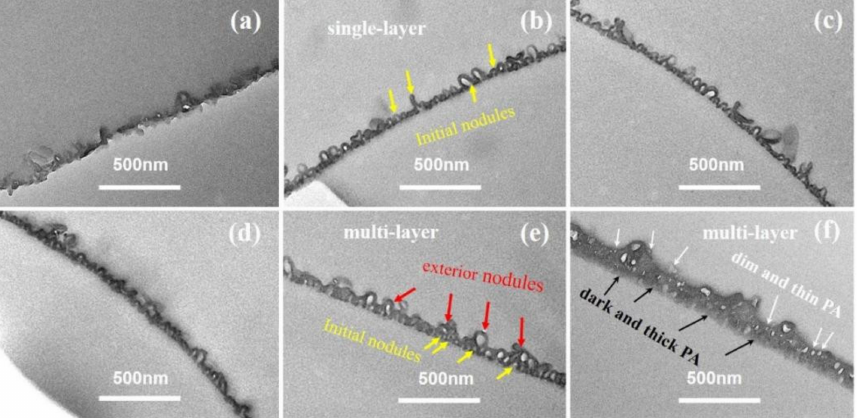
Figure 9. TEM images of cross-section parts of the PA membrane, ( a – f ): TFC − 13~TFC −